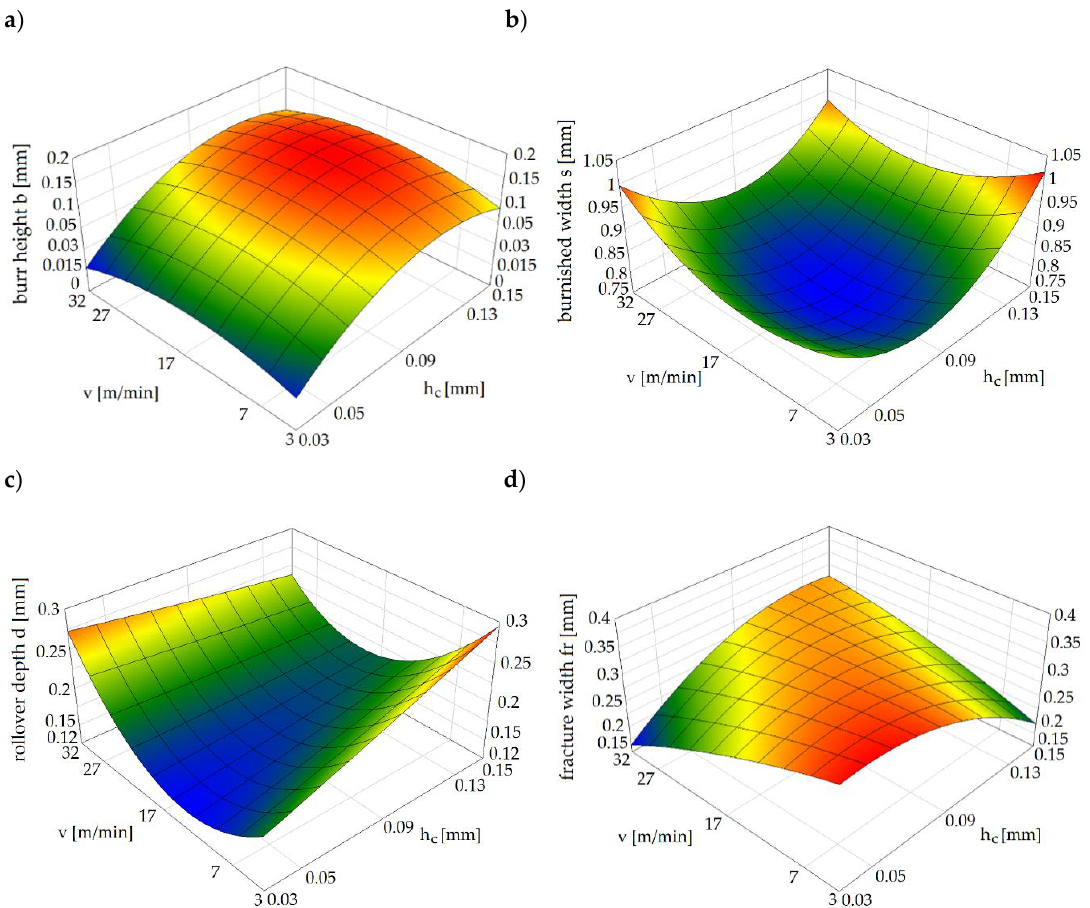
Figure 8. Influence of the selected process parameters on the: ( a ) burr, ( b ) burnish, ( c ) rollover, and ( d ) fracture zones.